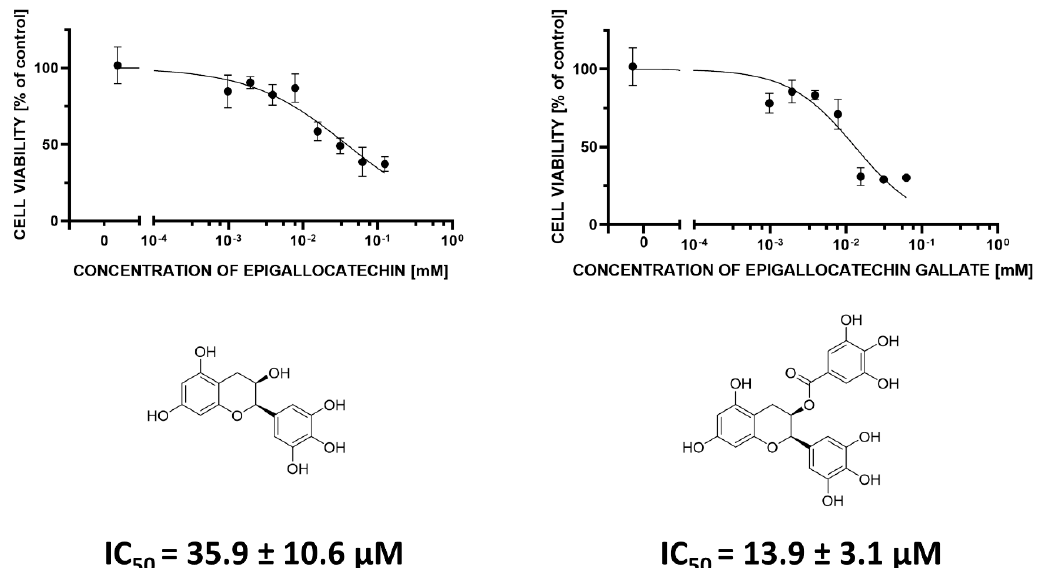
Figure 6. IC 50 values for epigallocatechin and epigallocatechin gallate in MCF-7 cellular model.